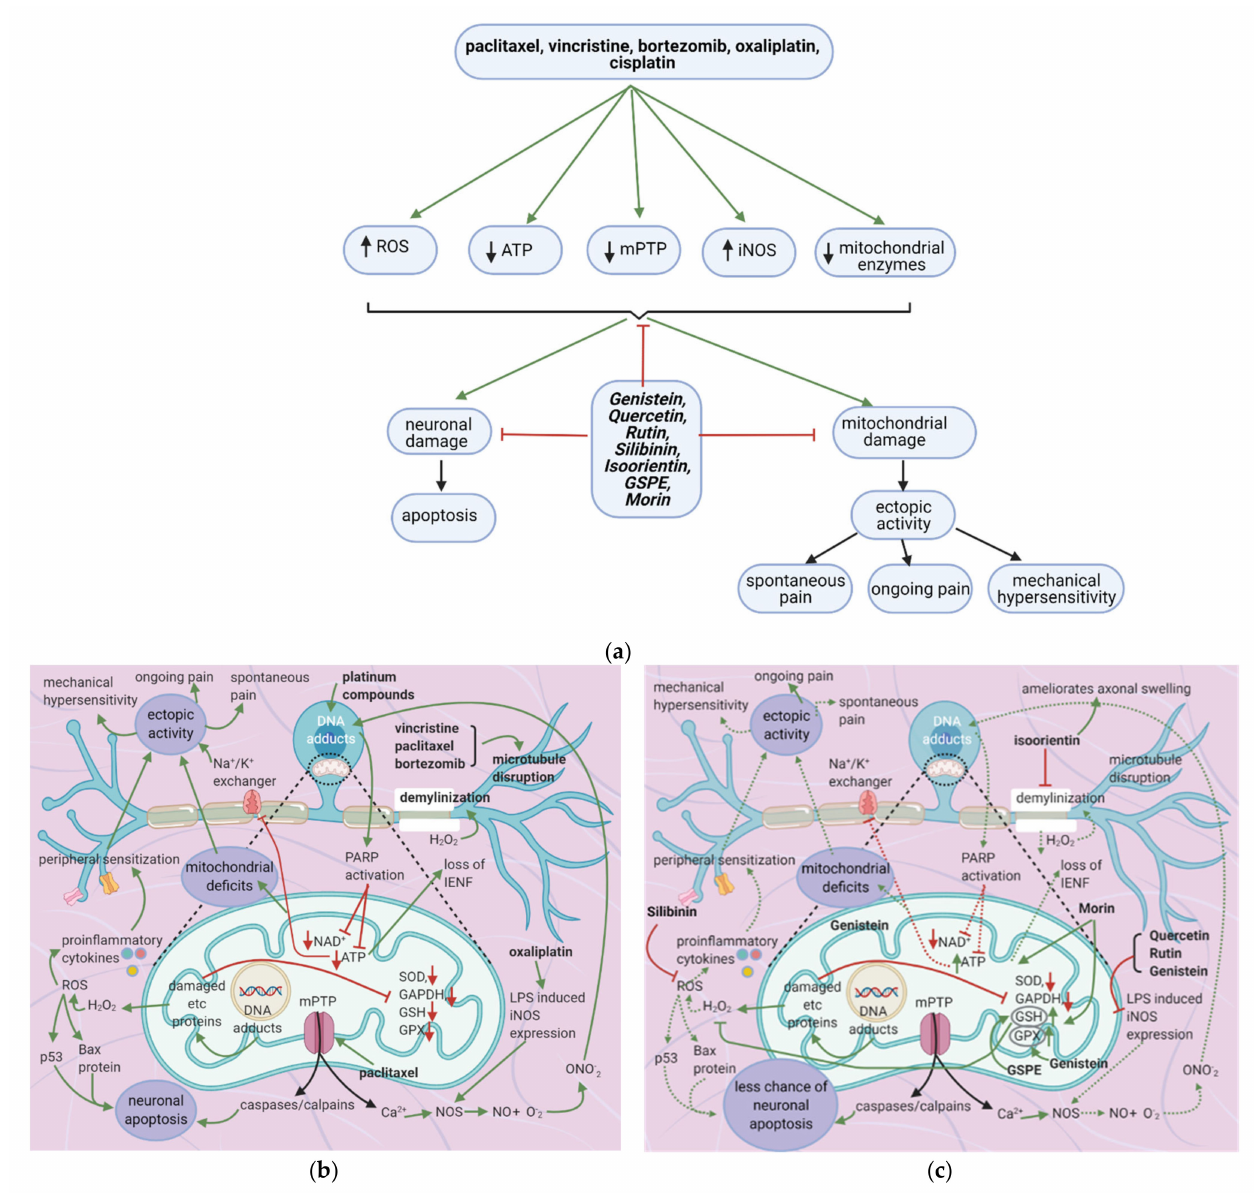
Figure 7. Anticancer drugs cause neuronal injury, and flavonoids counter these effects; ( a ) Simplified Overview of how flavonoids counter neuronal injury induced by anticancer drugs ( b ) Mechanisms of neuronal injury by anticancer drugs. Mitochondrial damage and sensitization of primary afferent channels cause ectopic discharges, which contribute to spontaneous pain, ongoing pain, and mechanical hypersensitivity; ( c ) Flavonoids alleviate neuronal damage caused by anticancer drugs, reducing spontaneous pain, mechanical hypersensitivity, and the likelihood of